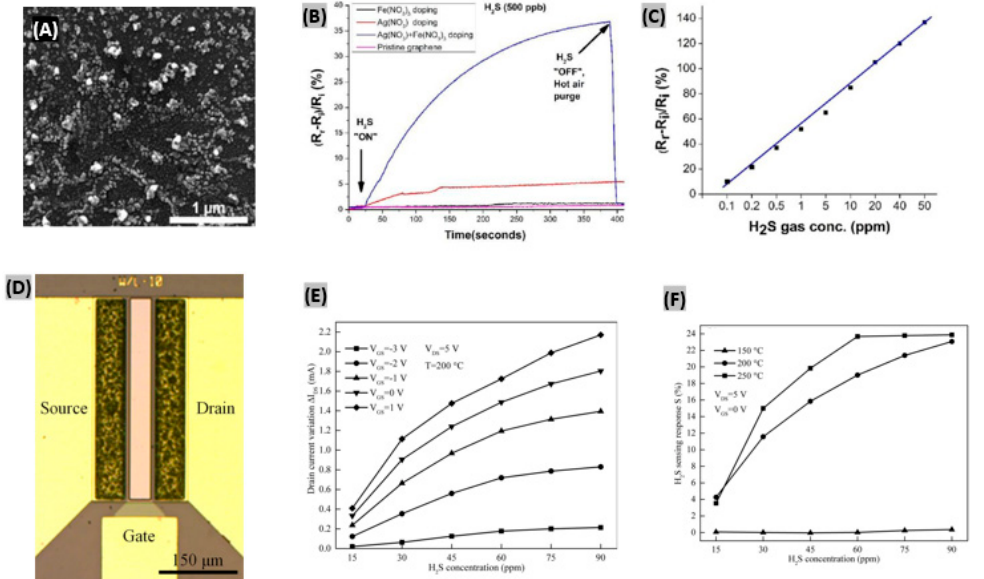
Figure 12. ( A ) SEM image of graphene after immersion into AgNO 3 /Fe(NO 3 ) 3 solution. ( B ) Comparative sensor responses of pristine graphene, graphene doped with Fe(NO 3 ) 3 solution, graphene doped with AgNO 3 solution, and graphene doped with mixed Fe(NO 3 ) 3 and AgNO 3 solution. ( C ) Relationship between H 2 S gas concentrations and corresponding relative responses of the fabricated sensor. Figures adapted with permission from [152], Copyright 2017 Elsevier. ( D ) Top view of the optical micrograph of the fabricated Pt-AlGaN/GaN HEMT sensor. ( E ) Changes in drain current with different concentrations of H 2 S gas and gate biases at T = 200 ◦ C, VDS = 5 V. (F) Sensitivity of the fabricated sensor toward H 2 S at different temperatures. Figures adapted with permission from [155], Copyright 2018